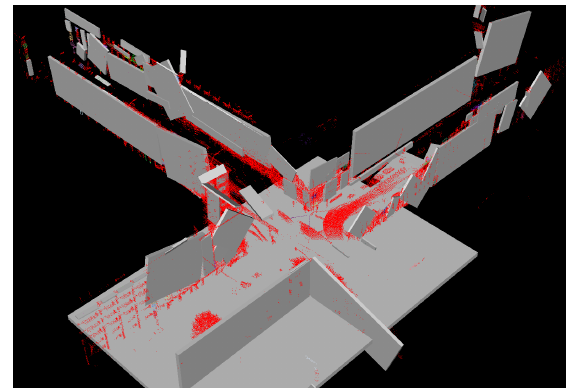
Figure 6. Planar surfaces (gray) extracted from an examplary point cloud (red). Most planar surfaces are correctly approximated. Some oriented bounding boxes are not aligned correctly. Figure 7. Anomalies caused by the plane-filtered raycasting. (a) A moving car classified as solid due to the plane fitted onto its roof. (b) Object border traversal artifacts. (c) Tree trunks are solid, but leafs are recognized as moving objects (red= solid , blue= moving object